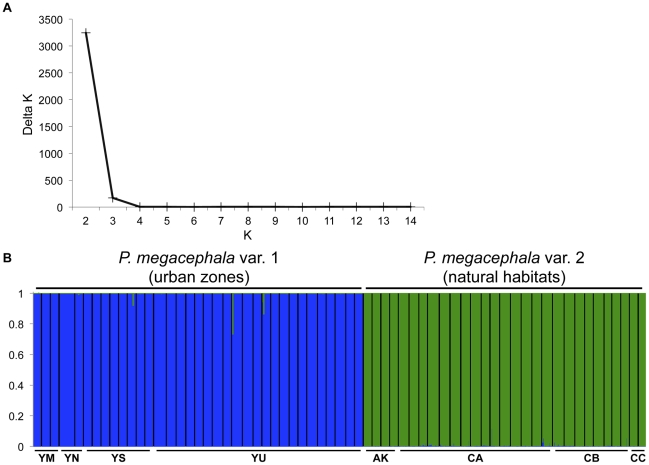
Bayesian cluster analysis.A: ΔK (a measurement of the rate of change in the structure likelihood function) values as a function of K, the number of putative supercolonies. In this case, K = 2. B: Graphical representation of the data set for the most likely K = 2, where each colour corresponds to a suggested cluster and each individual is represented by a vertical bar. The populations are indicated in the X-axis (AK: Akok; CA, CB and CC: Campo Forest Reserve; YM, YN, YS and YU: Yaoundé and its periphery). The Y-axis represents the probability for which an individual will be assigned to each cluster.